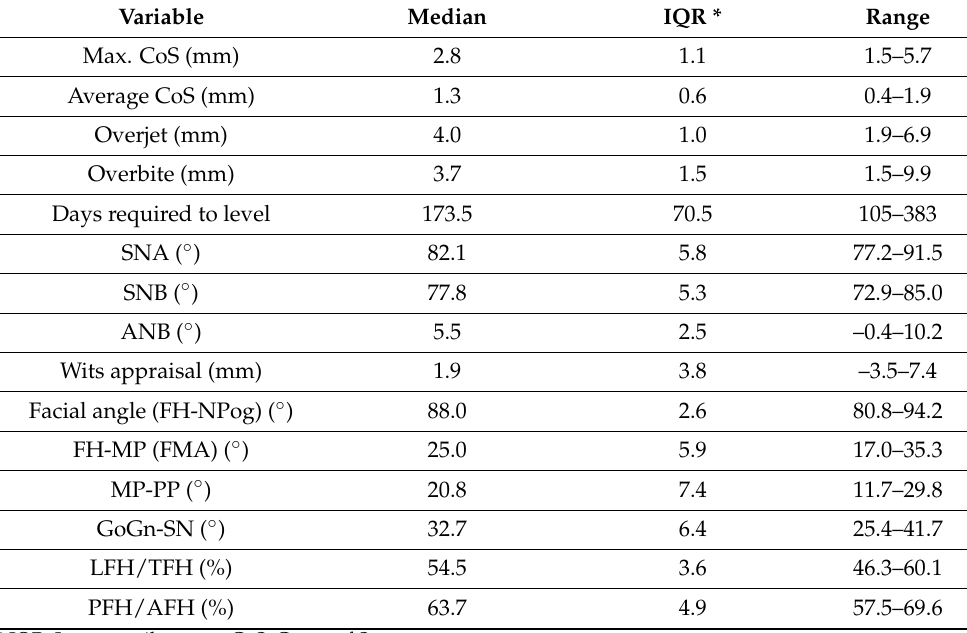
Table 1. Descriptive statistics of all variables analysed in the study.